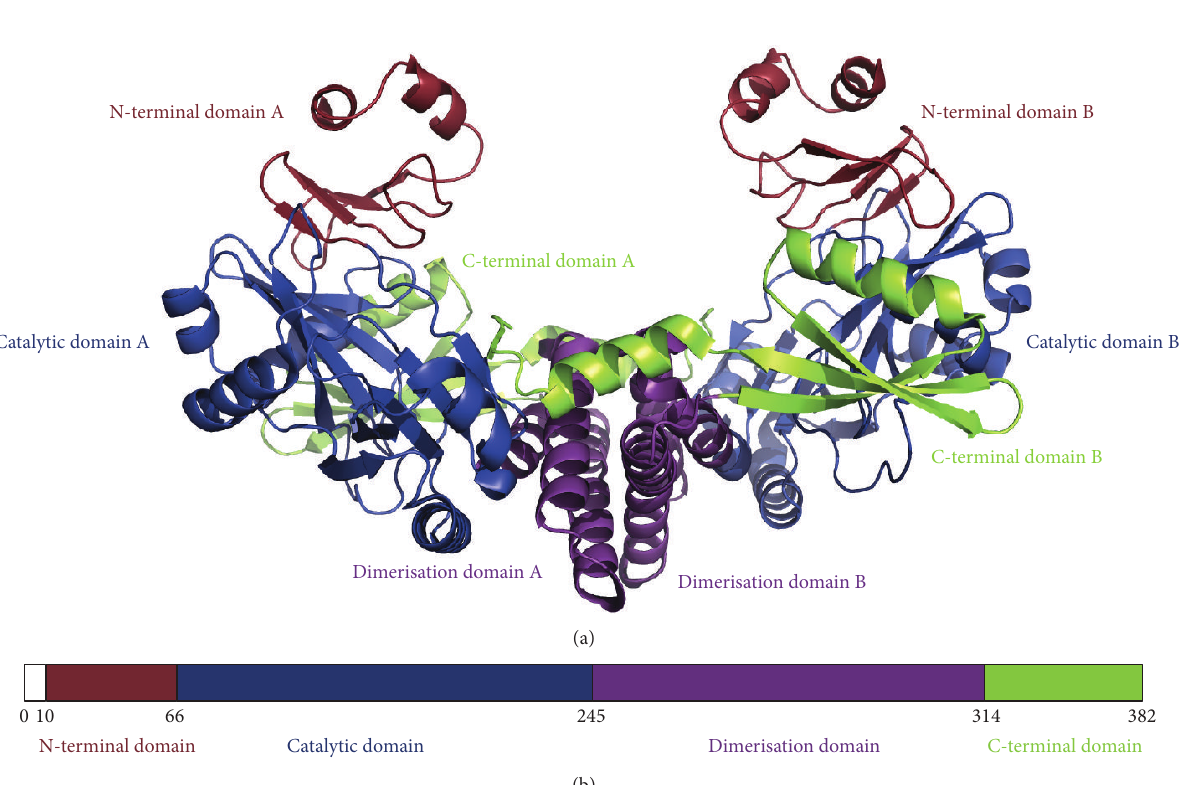
Figure 2: The Pyrococcus abyssi RNA ligase. (a) The homodimeric structure of the enzyme (PDB ID 2VUG). The four domains of each monomer are coloured individually and labelled. (b) Schematic diagram of the domain boundaries, with amino acid numbering